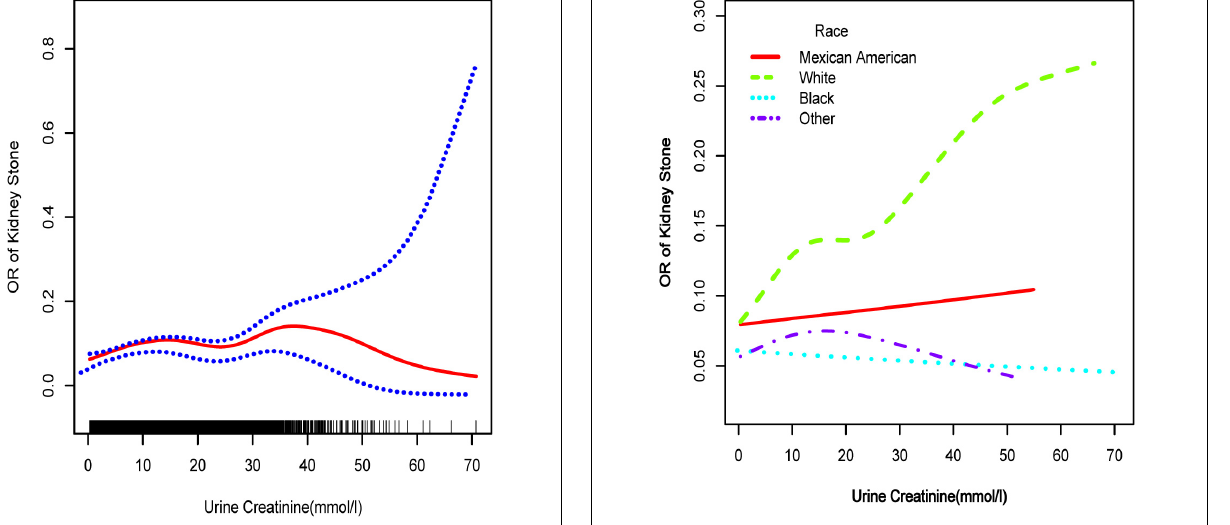
FIGURE 1 | Smooth curve fittings model, adjusted age, sex, race, education, marital status, annual household income, diabetes, systolic blood pressure, diastolic blood pressure, BMI, glycosylated hemoglobin, blood urea nitrogen, total cholesterol, serum calcium, total triglyceride, total protein, serum glucose, serum uric acid, and serum creatinine. The central part of the two blue curves designates 95% CI.